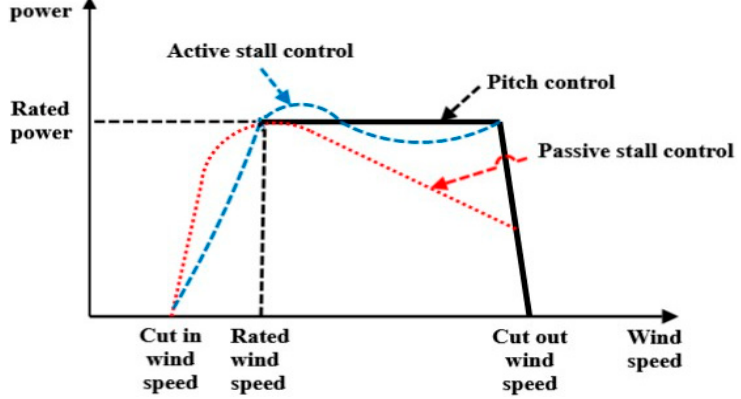
Figure 5. Power control of WTs.